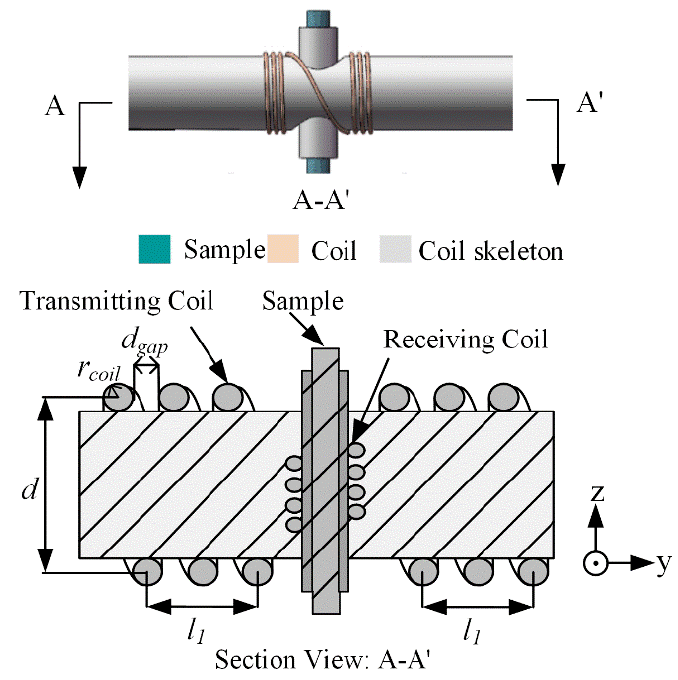
Figure 5. The section view of the orthogonal dual-coil probe.